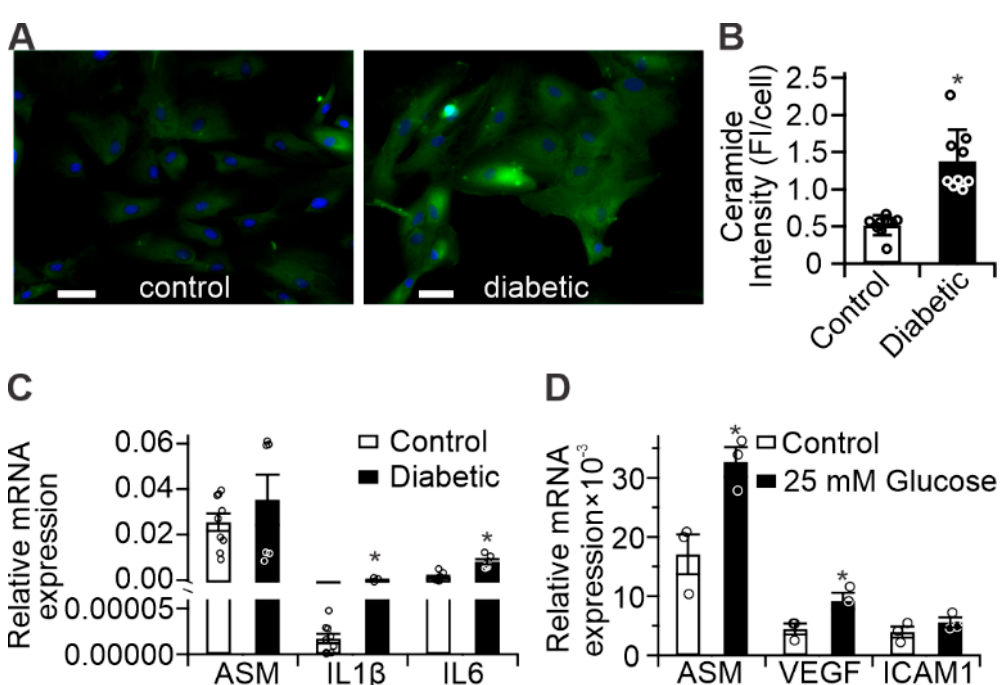
Figure 2. Diabetes-induced pro-inflammatory changes in human RPE ( A ) Representative images of control- and diabetic-derived retinal pigment epithelial (RPE) cells showing ceramide (green) and nuclear staining (blue). Scale bars = 50 µ m; ( B ) Quantitation of ceramide-staining fluorescence intensity from panel (A). n = 9, error bars = S.D., * p < 0.05; ( C ) Inflammatory gene expression in diabetic-derived RPE (black bars) compared to control (white bars); ( D ) Upregulation of inflammatory gene expression in control RPE treated with 25 mM glucose for 72 h (black bars) compared to untreated cells (white bars). * p < 0.01, n = 6.